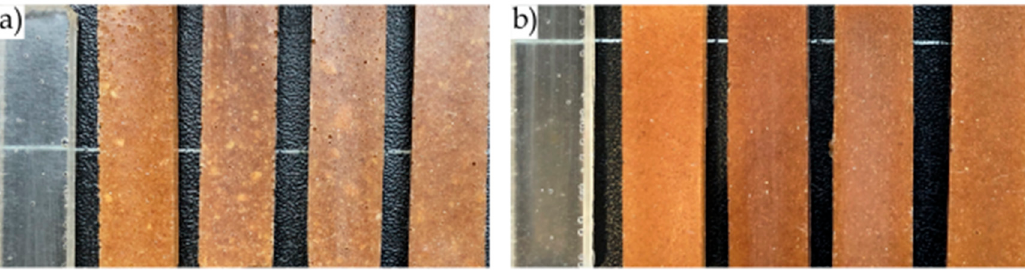
Figure 8. Visual aspect of BioEP and BioEP composites reinforced with different FF content; ( a ) (left to right) BioEP resin and BioEP composites reinforced with 10, 20, 30 and 40 wt % of CFF; ( b ) (left to right) BioEP resin and BioEP composites reinforced with 10, 20, 30 and 40 wt % of FFF.